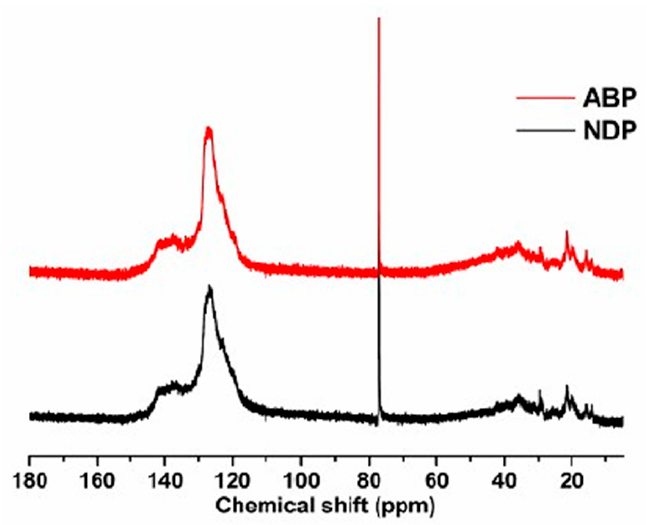
Figure 3. 13 C-NMR spectra of the NDP and the ABP. Table 2. Normalized integration data based on the 13 C NMR spectra.